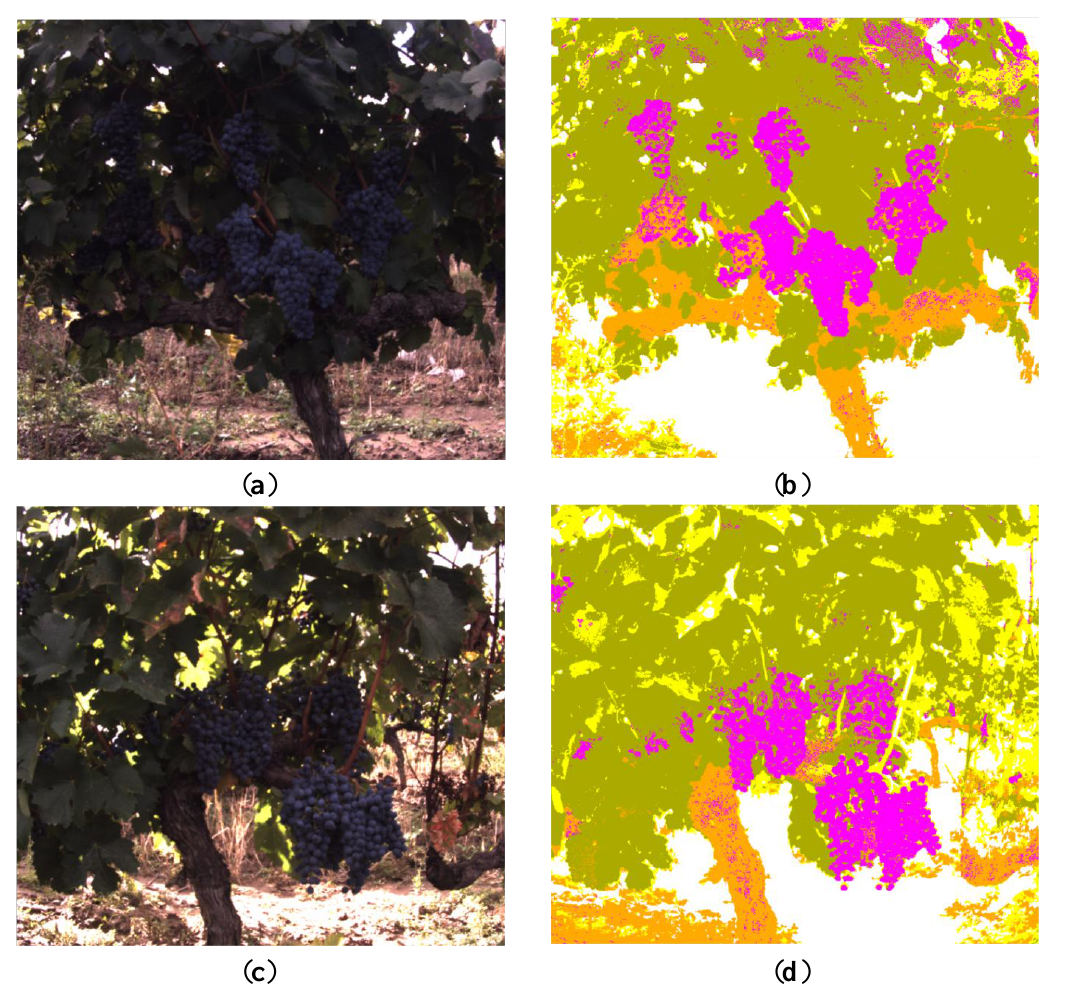
Figure 12. ( a ) Original RGB image—scene 2; ( b ) Clustered image—scene 2; ( c ) Original RGB image—scene 3; ( d ) Clustered image—scene 3.